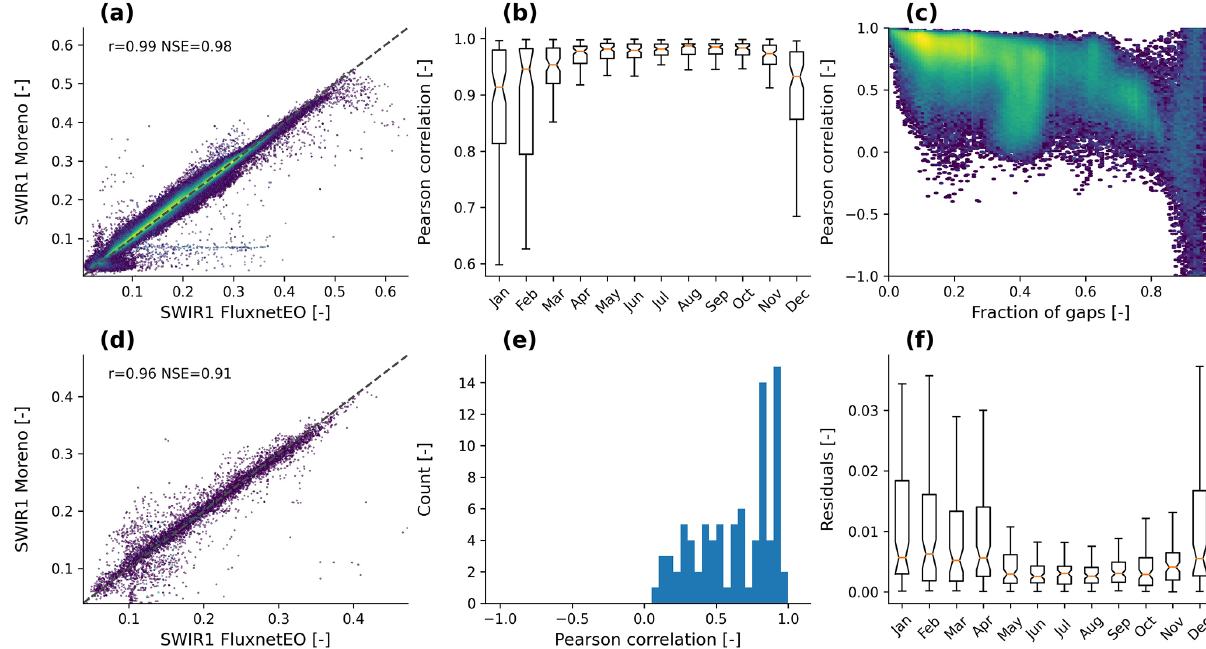
Figure C6. Same as Fig. C3 but for the first shortwave infrared spectral band.